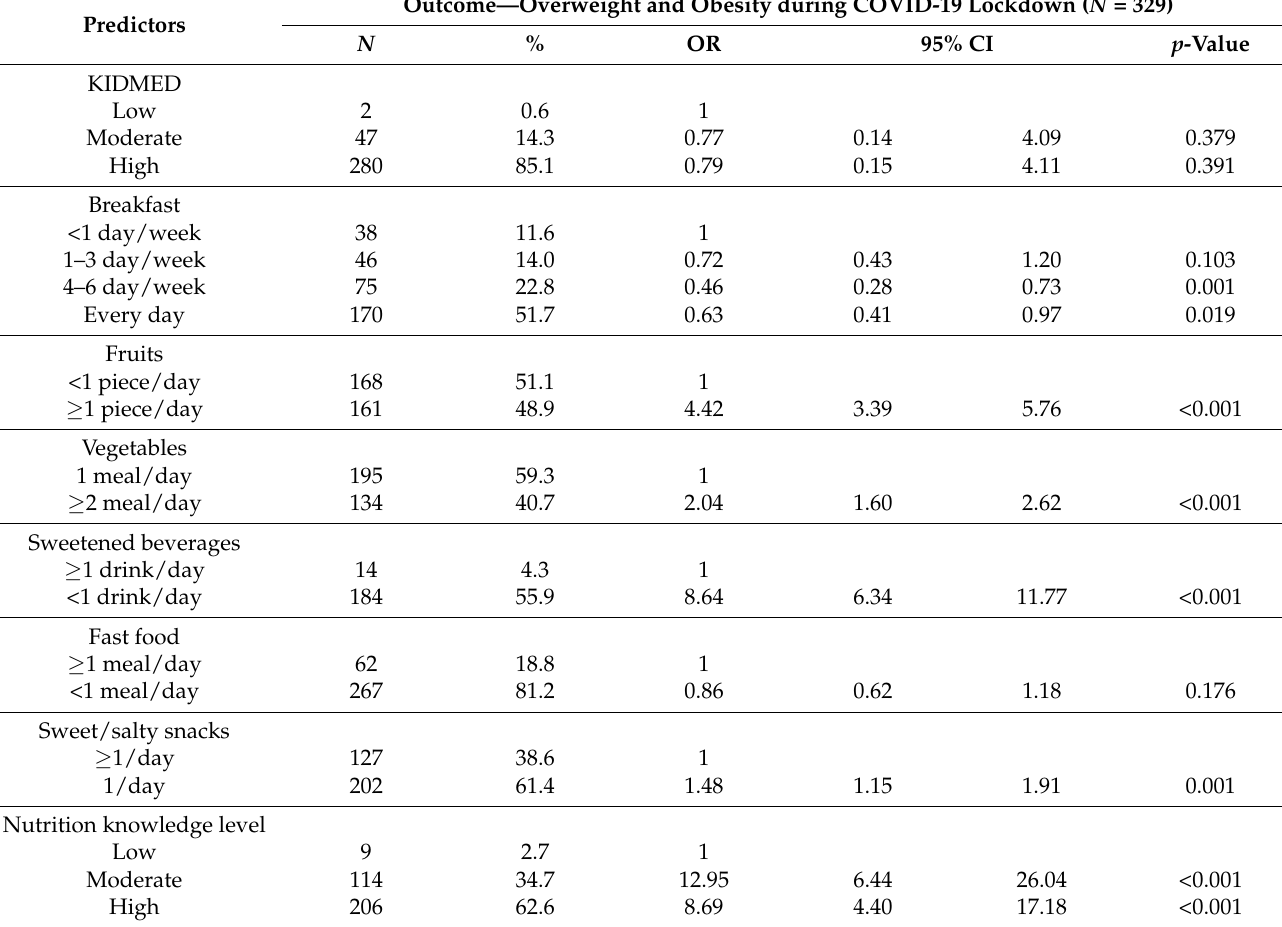
Table 5. Association of participants’ dietary habits and nutrition knowledge to overweight and obesity during COVID- 19